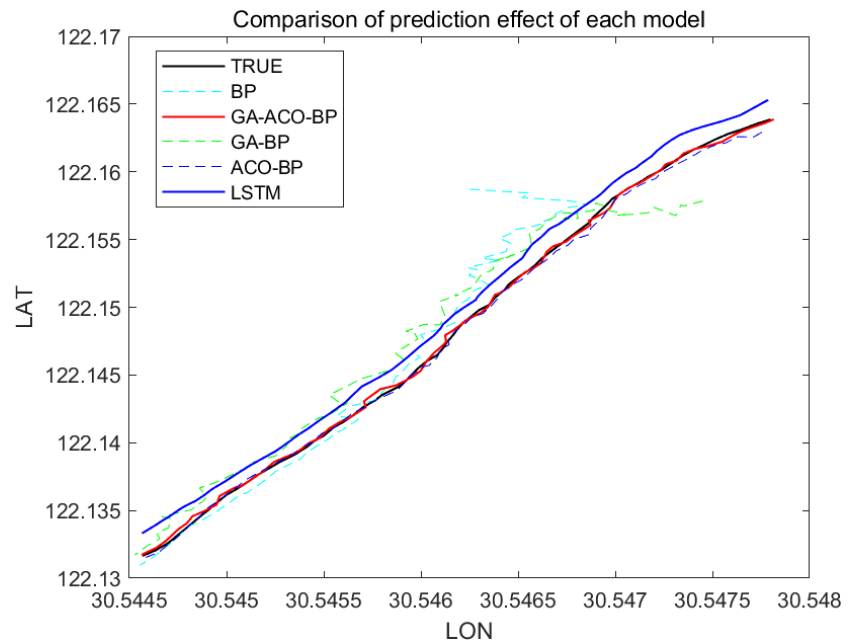
Figure 11. Comparison of track prediction effects of each model (YangShan port).